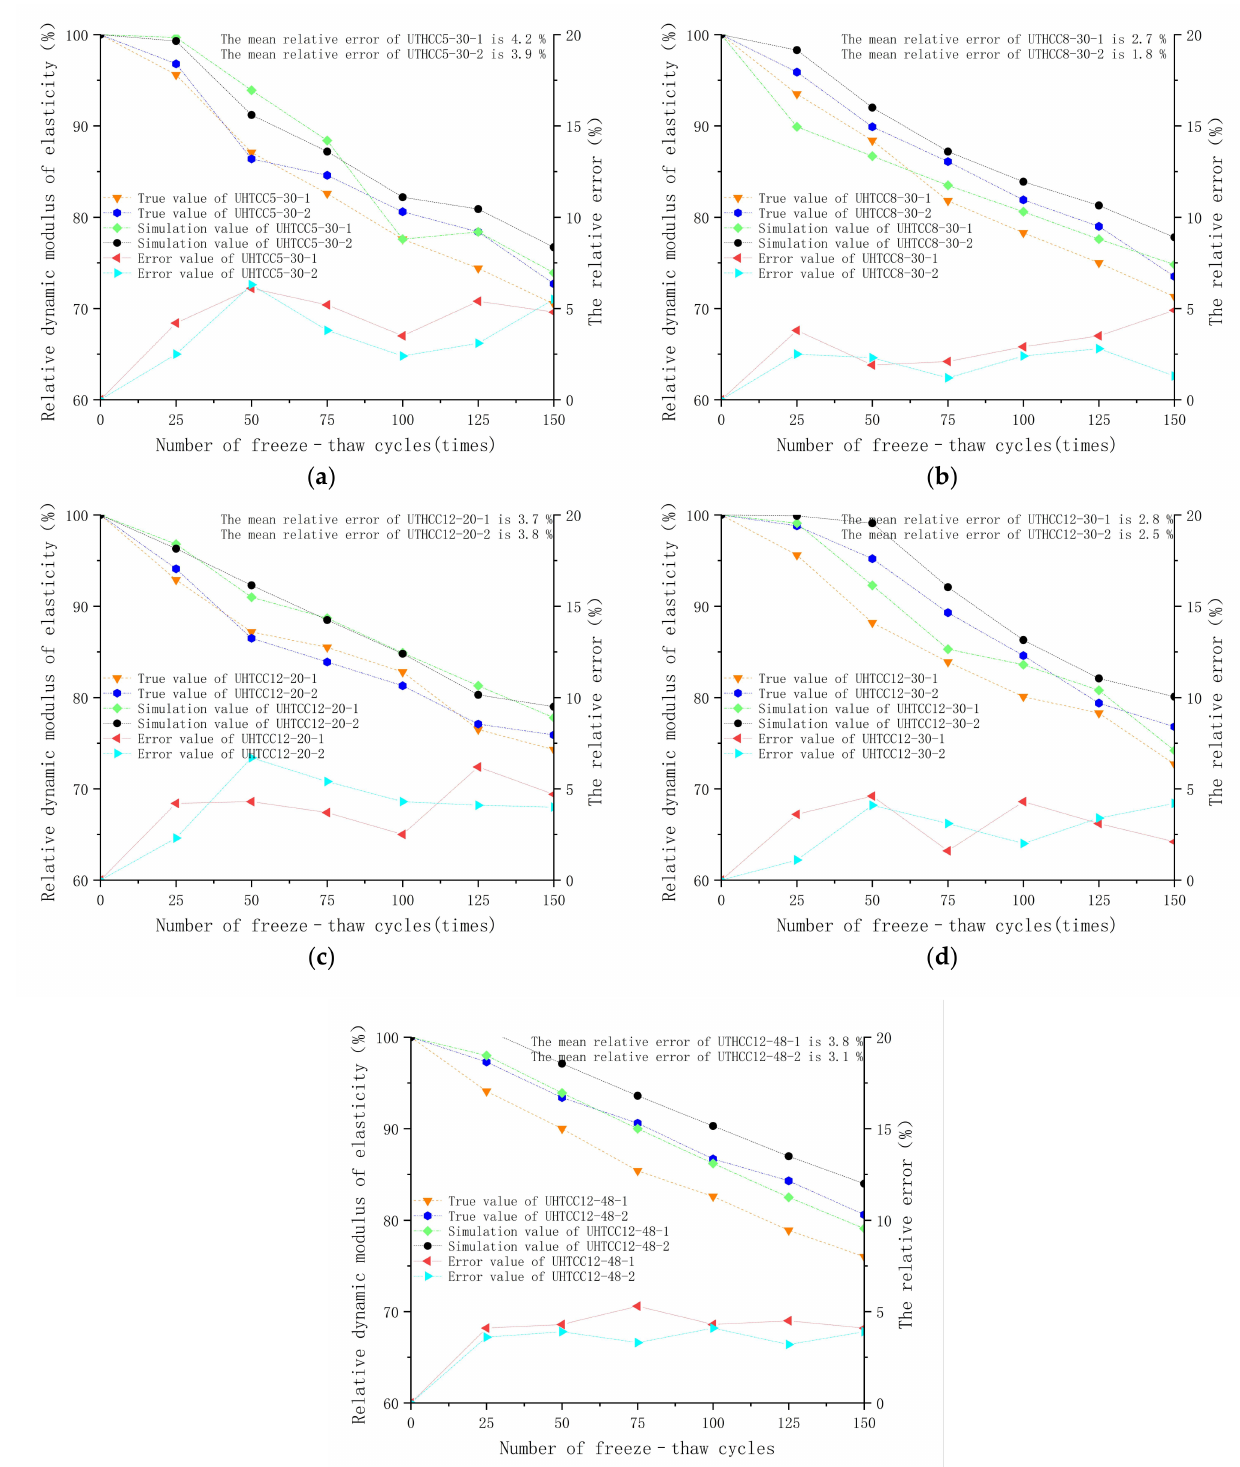
Figure 8. Error analysis of the GM(1,1) power model: ( a ) uhtcc5-30; ( b ) UHTCC8-30; ( c ) UHTCC12-20; ( d ) UHTCC12-30; ( e )